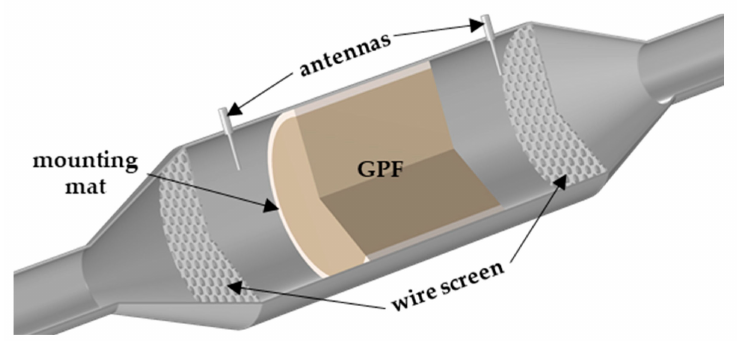
Figure 9. Geometry of the simulation model; the grids before and after the GPF were not considered in the flow simulation.